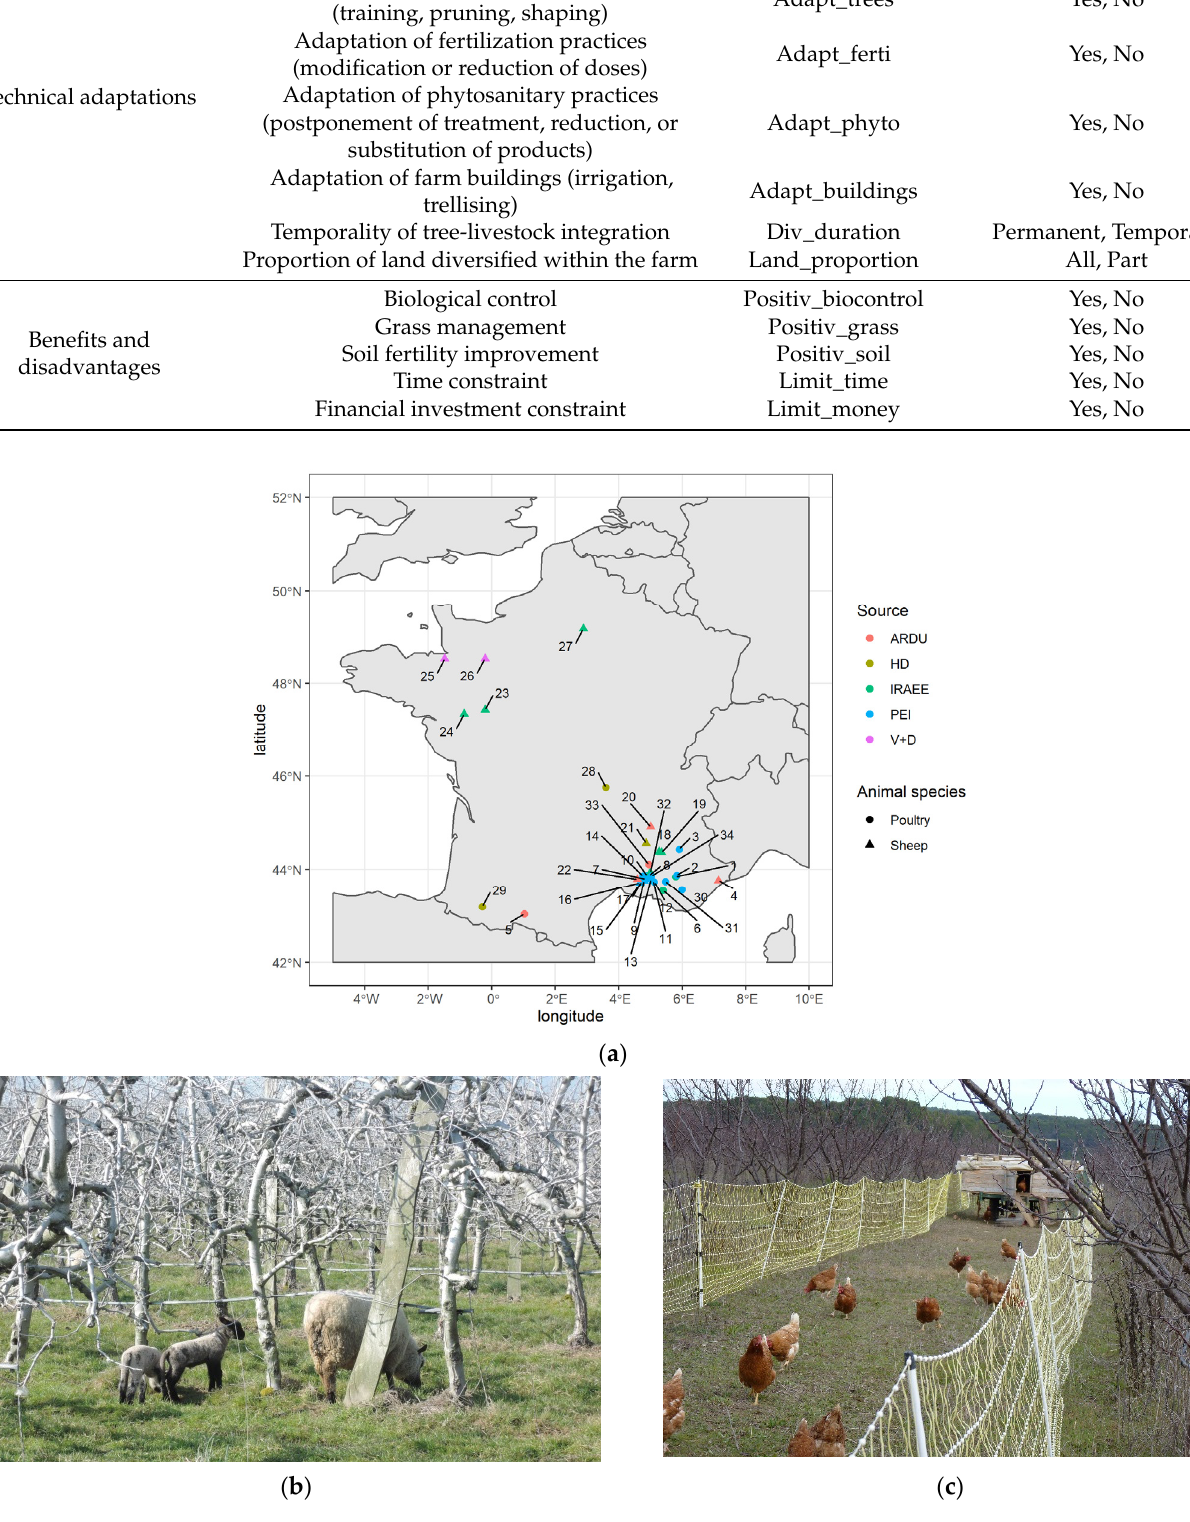
Figure 1. ( a ) Map of the 34 surveyed farms, France; ( b ) sheep (Shropshire breed) and commercial apple, Farm no. 24 ( Malus Domestica) ; ( c ) laying hens and commercial apricot ( Prunus Armeniaca ), Farm no. 6 (photo credits: M. Compagnone).